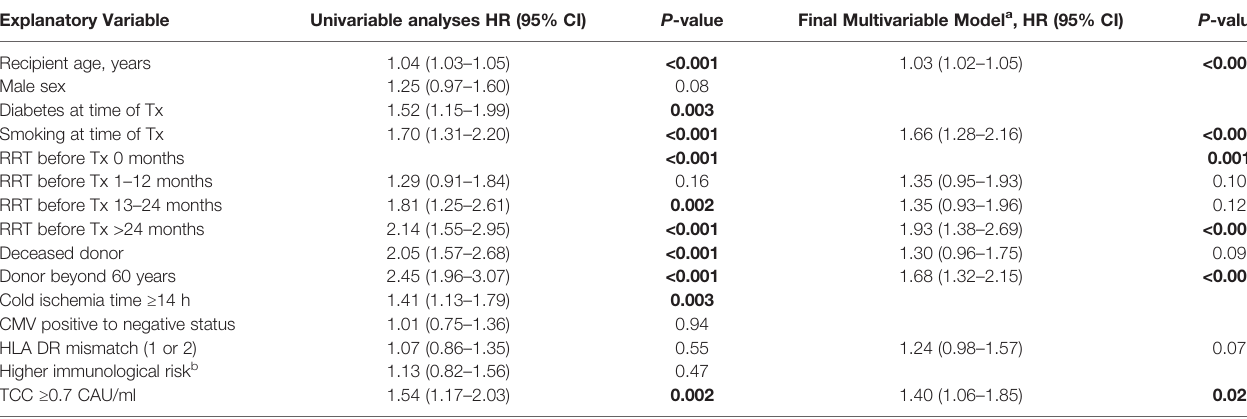
TABLE 3 | Univariable and multivariable Cox regression models with TCC for overall (uncensored) graft survival after kidney transplantation 2007 – 2012, n = 900. Explanatory Variable